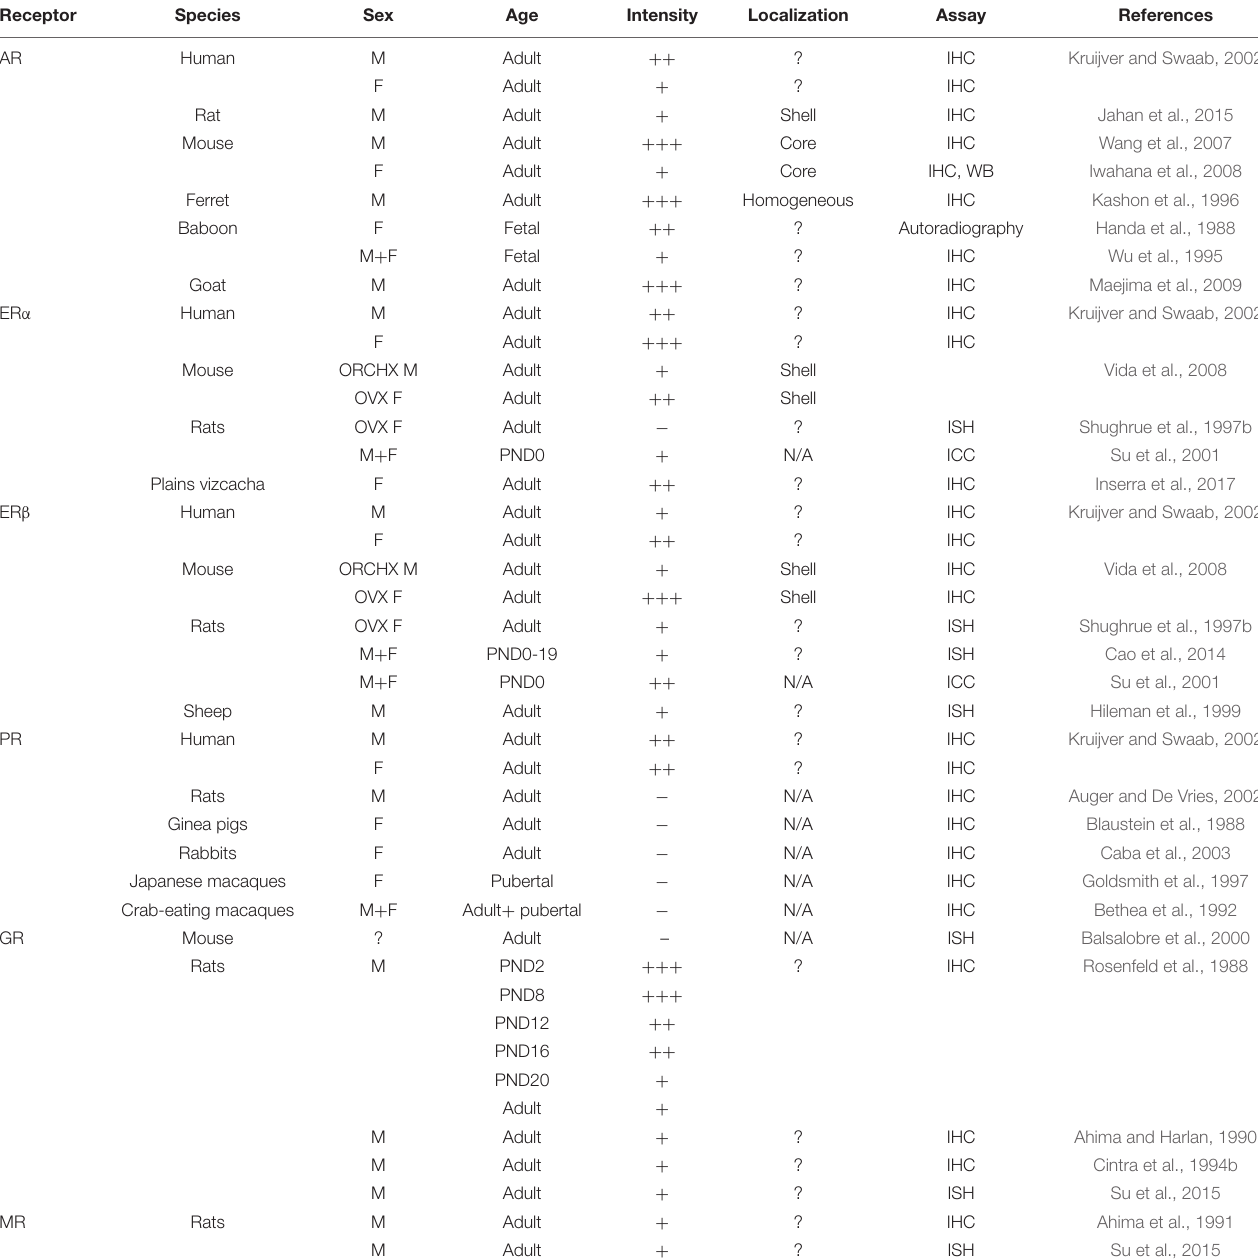
TABLE 3 | Density of steroid receptors in the SCN. Receptor Species Sex Age Intensity